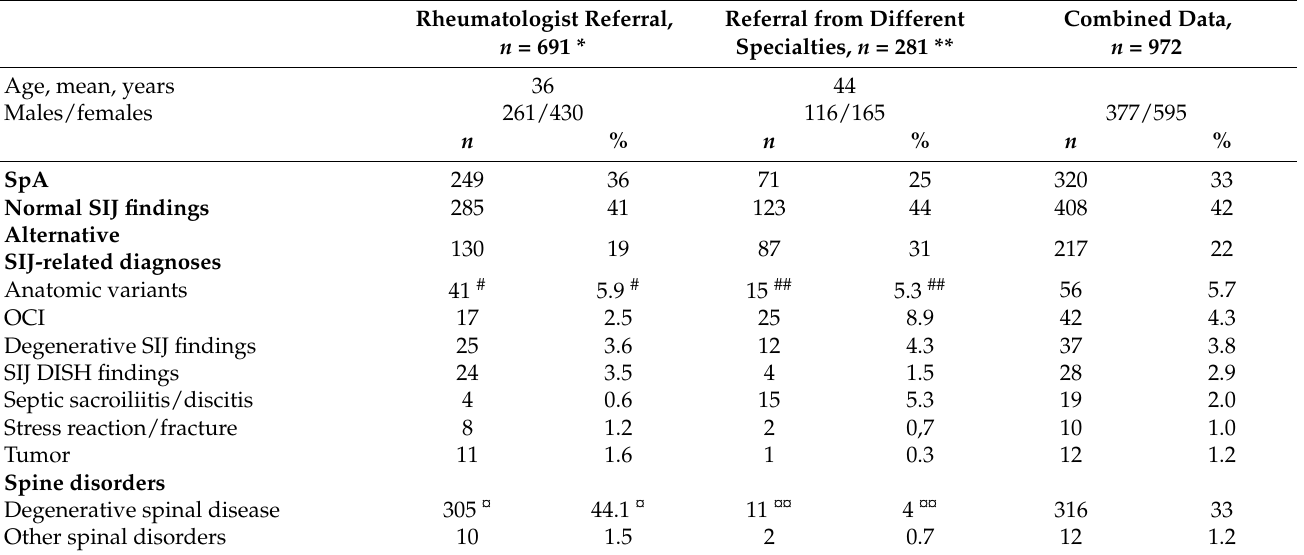
Table 1. Reported final diagnoses in patients with low back pain and suspected sacroiliitis examined by MRI